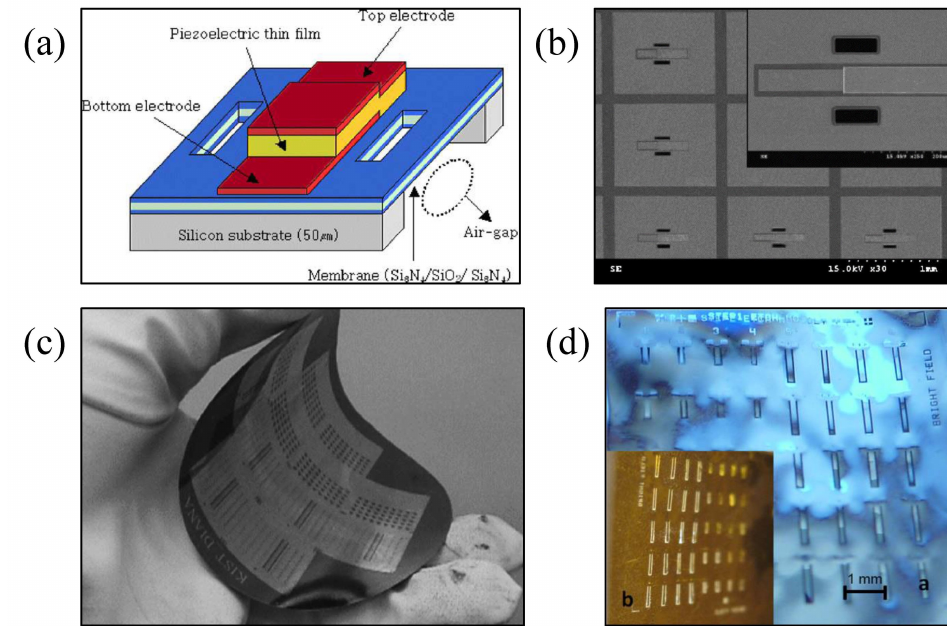
Figure 6. ( a ) Structure and ( b ) SEM of an FBAR based on an ultra-thin flexible silicon substrate [93] Reprinted/adapted with permission from Ref. [93]. 2005, Elsevier. ( c ) Fabricated thin FBAR of wafer level with flexibility [93] Reprinted/adapted with permission from Ref. [93]. 2005, Elsevier. ( d ) MEMS resonant cantilevers based on flexible PI film [92] Reprinted/adapted with permission from Ref. [92]. 2012,